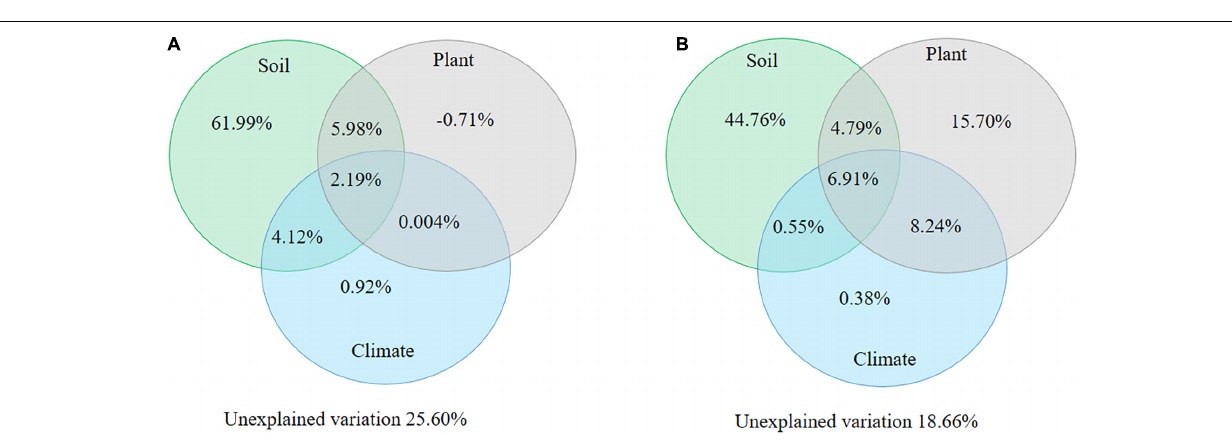
FIGURE 7 | Variation partitioning analysis of soil nitrogen: phosphorus (N:P) ratio in alpine shrublands (A) and desert shrublands (B) on the northeast Tibetan Plateau. Soil properties include soil N, soil organic carbon, and soil pH. Vegetation properties refer to stem N:P ratios and root N:P ratio alpine shrublands, root N:P ratio in desert shrublands, and shrublands types in all shrublands. Climate refers to mean annual precipitation. Variation partitioning analysis consists of explained variation, including the effects from the soil, climate, vegetation properties, and their combined effects, and unexplained